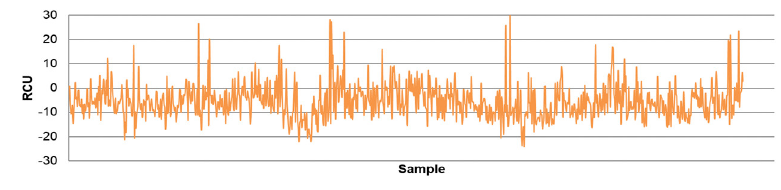
Figure A17. Prediction error of PMM model training dataset for RCU output variable.